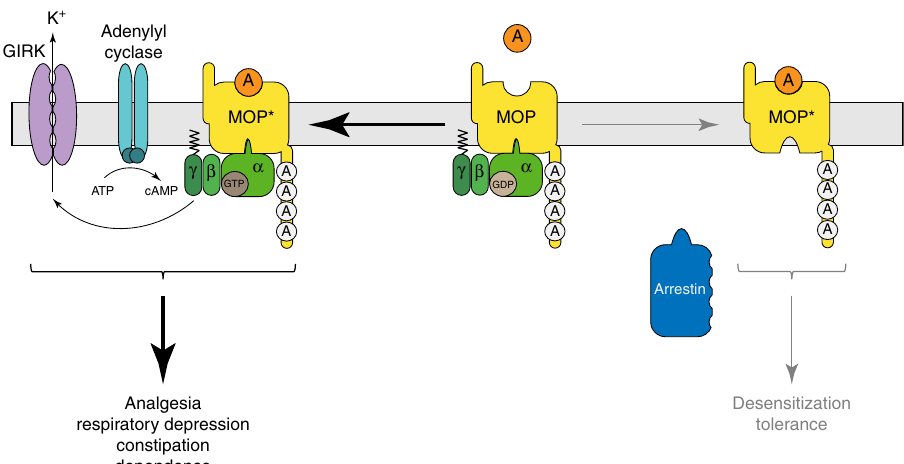
Fig. 6 Phosphorylation-de fi cient, G-protein-biased MOP receptors enhance analgesia, but worsen side effects. Carboxyl-terminal multisite phosphorylation is the key step that drives acute MOP receptor desensitization and long-term tolerance. In the absence of MOP phosphorylation, arrestin recruitment is increasingly impaired yet phosphorylation-de fi cient MOP receptors can mediate opioid side effects such as respiratory depression, constipation